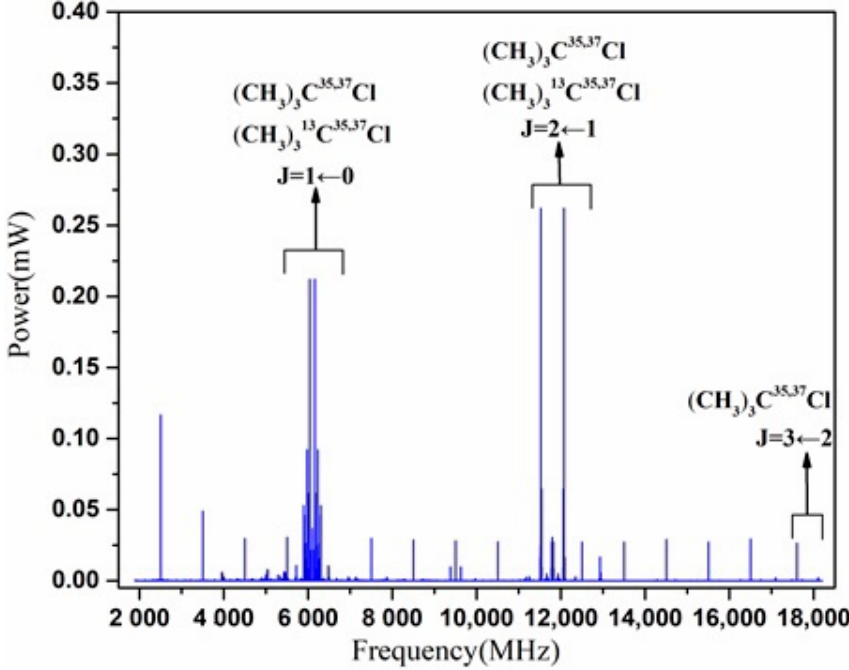
Figure 3. Diagram of the J = 1 ← 0 to J = 3 ← 2 rotational transitions of (CH 3 ) 3 C 35 Cl, (CH 3 ) 3 C 37 Cl, (CH 3 ) 313 C 35 Cl, (CH 3 ) 313 C 37 Cl detected in the 1–18 GHz frequency region.